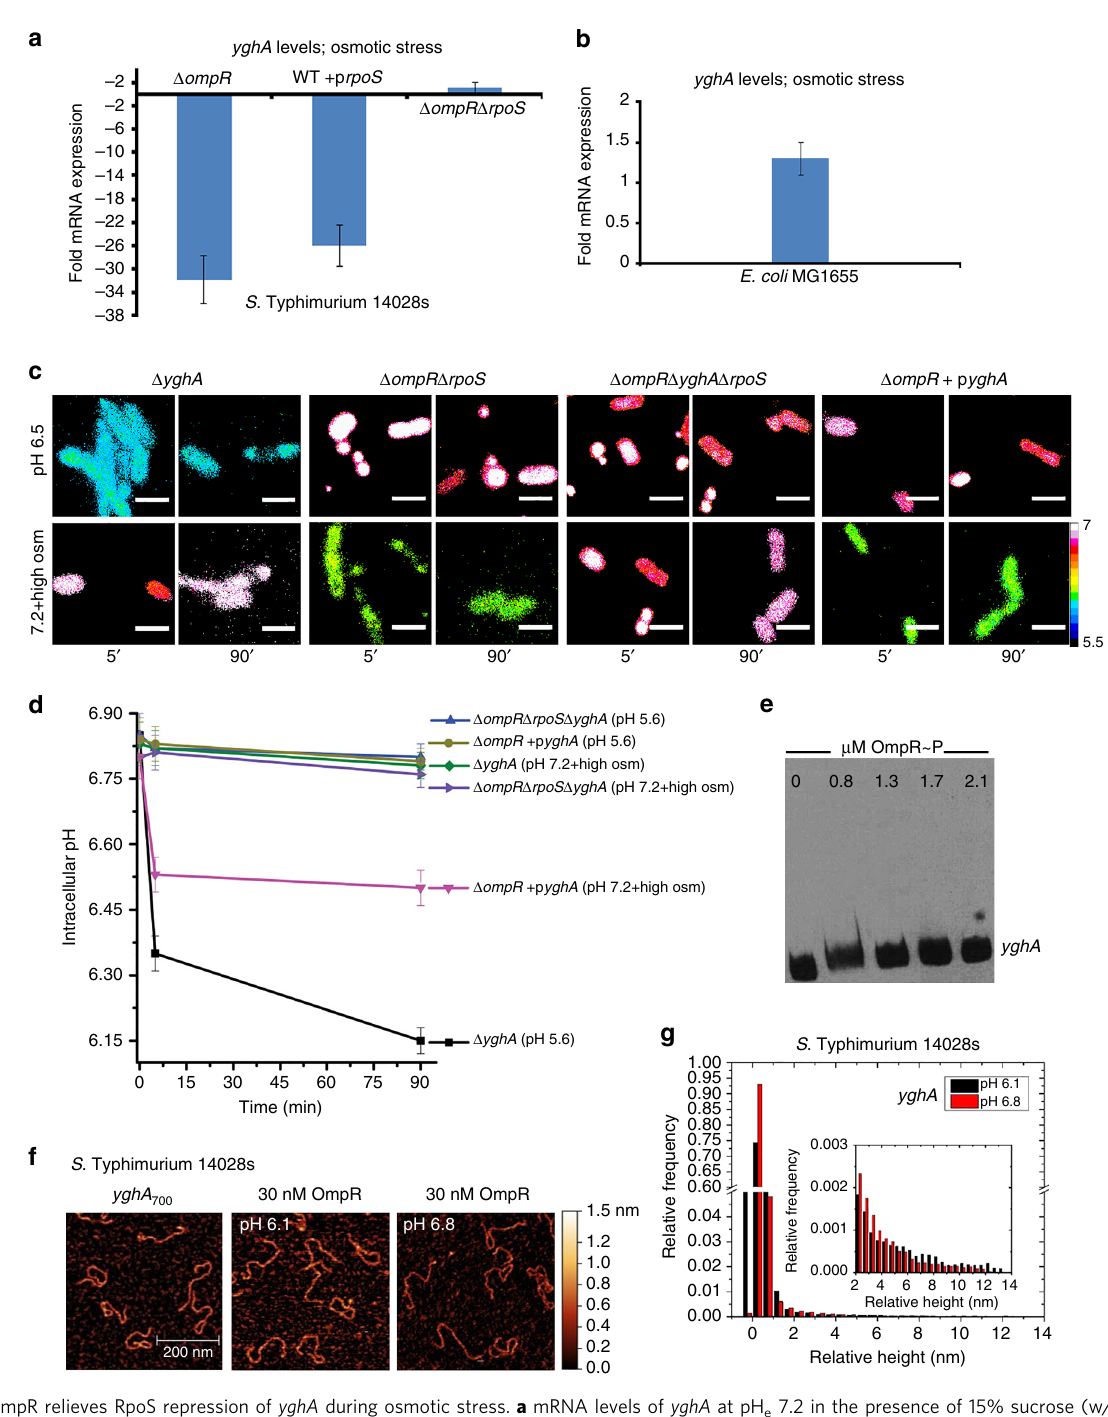
Fig. 3 OmpR relieves RpoS repression of yghA during osmotic stress. a mRNA levels of yghA at pH e 7.2 in the presence of 15% sucrose (w/v) were determined by qRT-PCR from wild type, an ompR null strain, an rpoS over-expressed strain, and an ompR/rpoS null strain of S . Typhimurium. Fold expression changes were compared to the wild-type level. Error bars represent the mean ± s.d. ( n = 6). b mRNA of yghA at pH e 7.2 in the presence of 15% sucrose (w/ v) of an E. coli ompR null strain was compared to the wild-type level. c Representative images of R 488/440 are shown after 5 and 90 min incubation at pH e 5.6, or pH e 7.2 + 15% (w/v) sucrose of a yghA null strain, an ompR / rpoS null strain, an ompR/rpoS/yghA null strain, and an ompR null strain of S. Typhimurium with yghA over-expressed. Scale bar, 3 μ m. d Plot of the R 488/440 ratios of various mutants of S. Typhimurium at each indicated time. Data set is represented as the mean ± s.e.m. ( n = 3). The complete graph, including all strains is in Supplementary Fig. 4. e EMSAs were performed with biotin end- labeled yghA and OmpR. f AFM images of yghA 700 from S . Typhimurium with 30 nM OmpR at either acid pH (6.1) or neutral pH (6.8). g Relative height distribution histogram of the yghA promoter complexed with 30 nM OmpR at either acidic or neutral